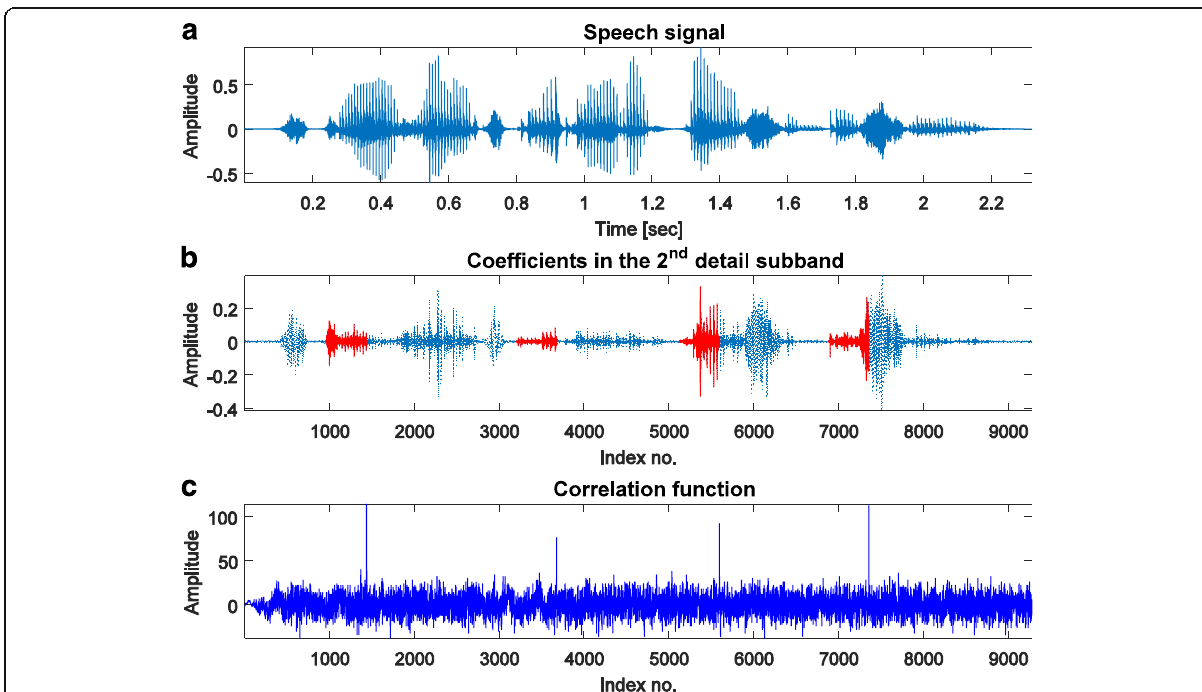
Fig. 2 a , c Detection of the synchronization code from a noise-corrupted speech signal with SNR = 30 dB. The leading three frames in each embeddable segment are particularly drawn in red in b